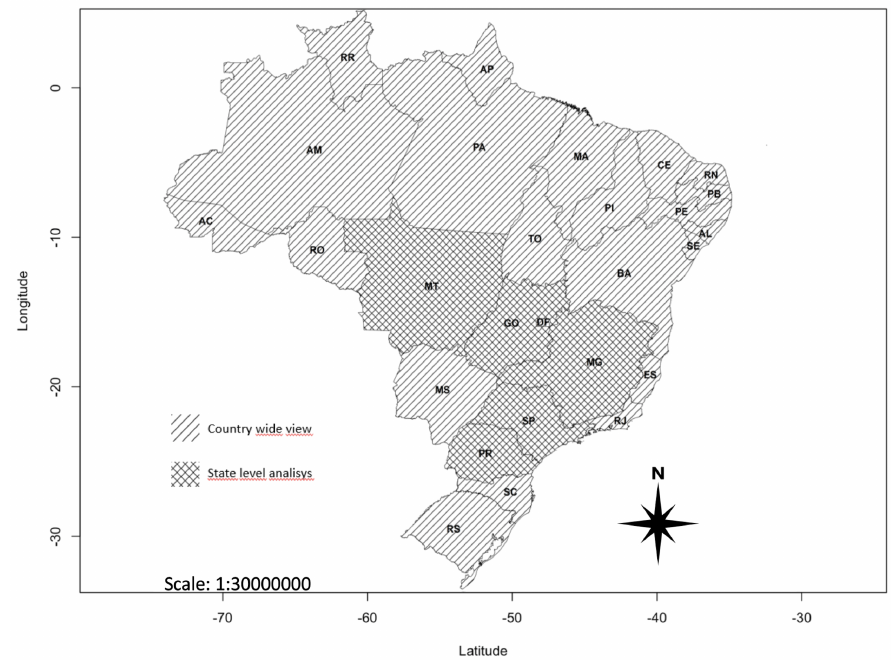
Figure 1. The experiment was performed over GO, MG, MT, PR, and SP, and a country-wide